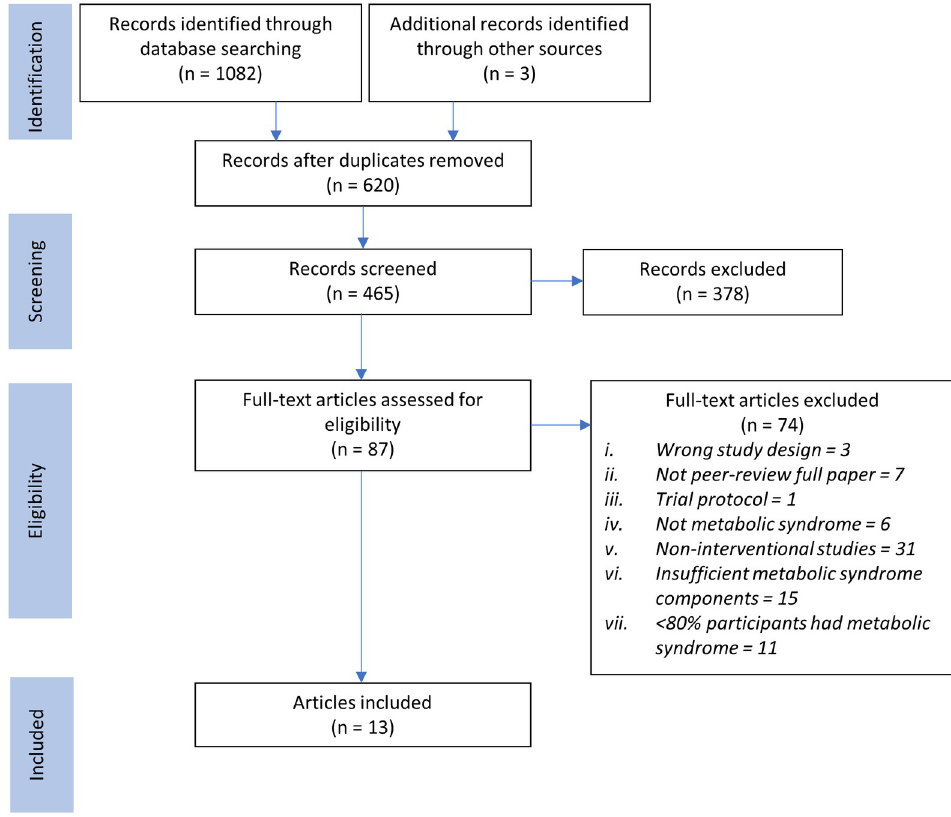
Fig 1. PRISMA 2020 flow chart delineating the study selection